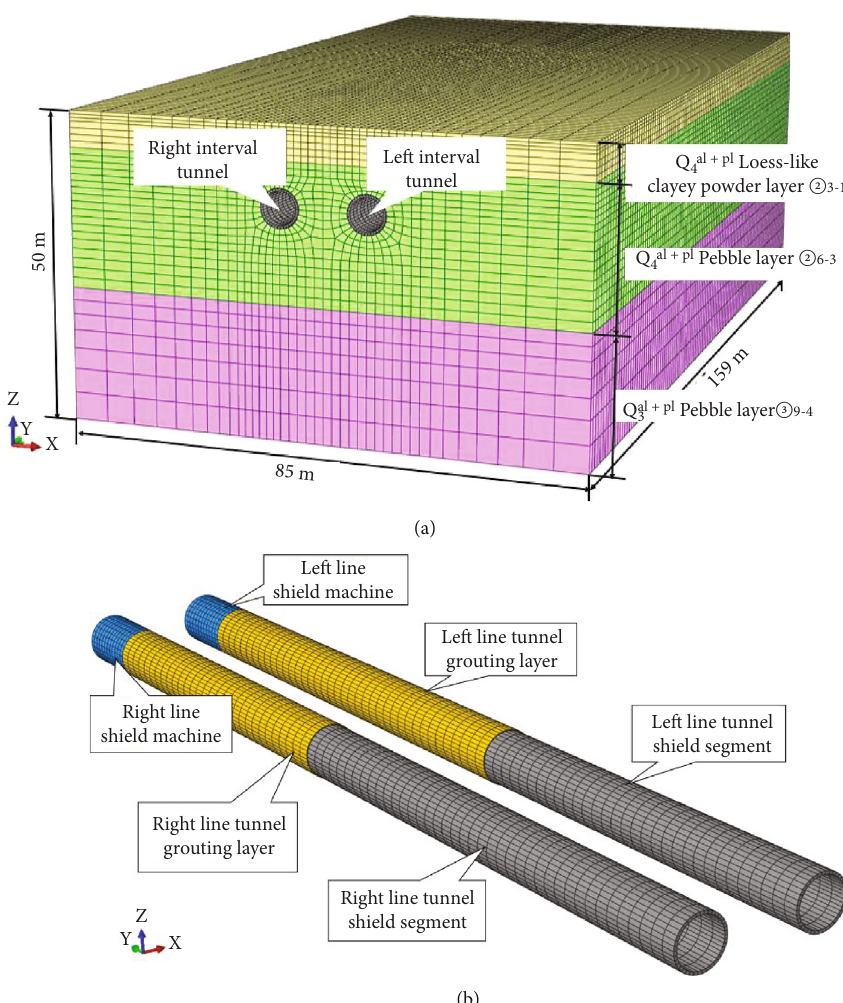
Figure 2: Calculation model: (a) soil layers and (b)